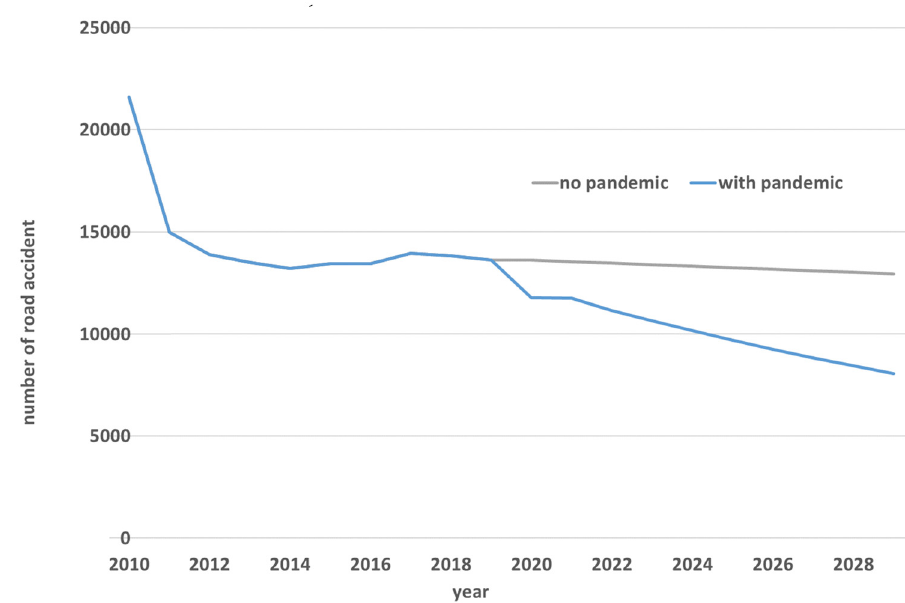
Figure 10: Comparison of the number of road accidents in Slovakia with and without the